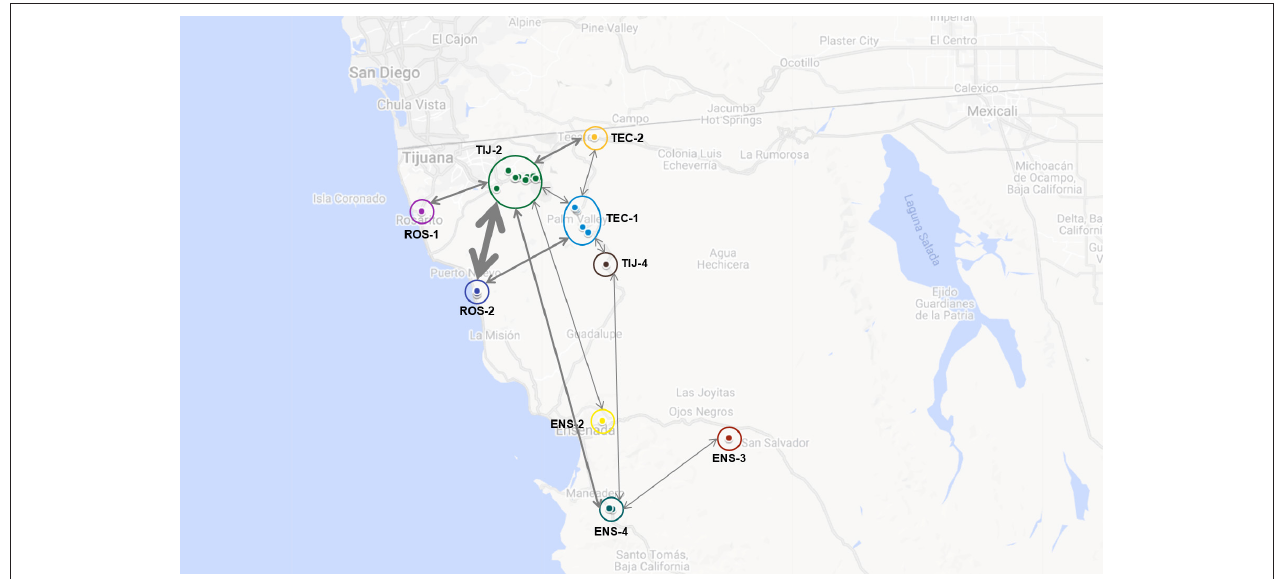
FIGURE 5 | Putative interaction among dairies based on the identification of one or more shared genotypes. Dairies’ clusters are indicated and labeled accordingly (ROS-1, ROS-2, TIJ-2, TIJ-4, TEC-1, TEC-2, ENS-2, ENS-3 and ENS-4). Bidirectional arrows are indicative of shared genotypes between dairy clusters and thickness is directly related to the number of shared genotypes (the thicker the arrow, the more shared genotypes). Map was built using GoogleMaps.